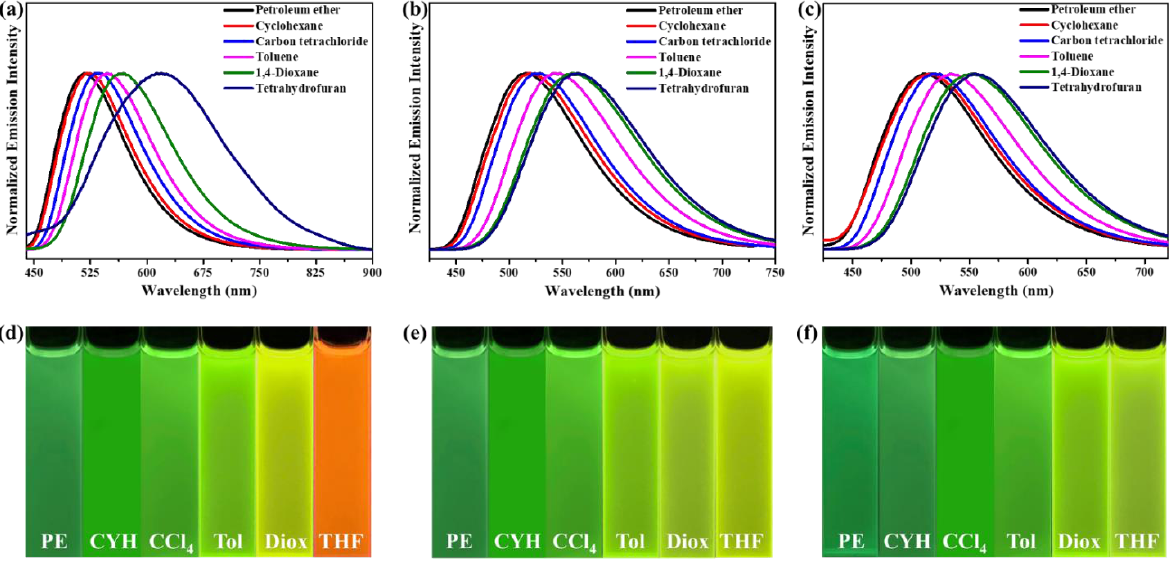
Figure 3. Normalized fluorescence spectra (Excitation wavelength = 365 nm) of compounds 1 – 3 ( a – c ) in different solvents. FL images of compounds 1 – 3 ( d – f ) in different solvents under 365-nm UV illumination. Concentration: 20 μM .